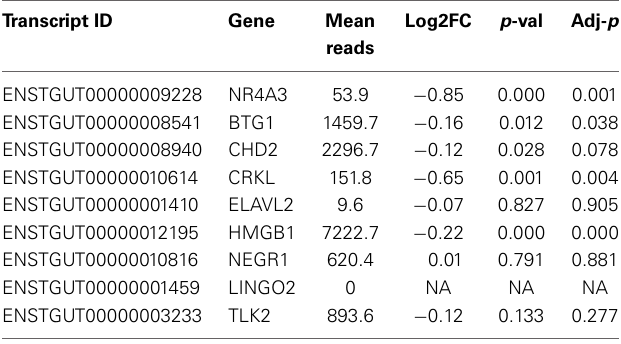
Table 2 | Differential expression testing of predicted target genes using RNA-seq and